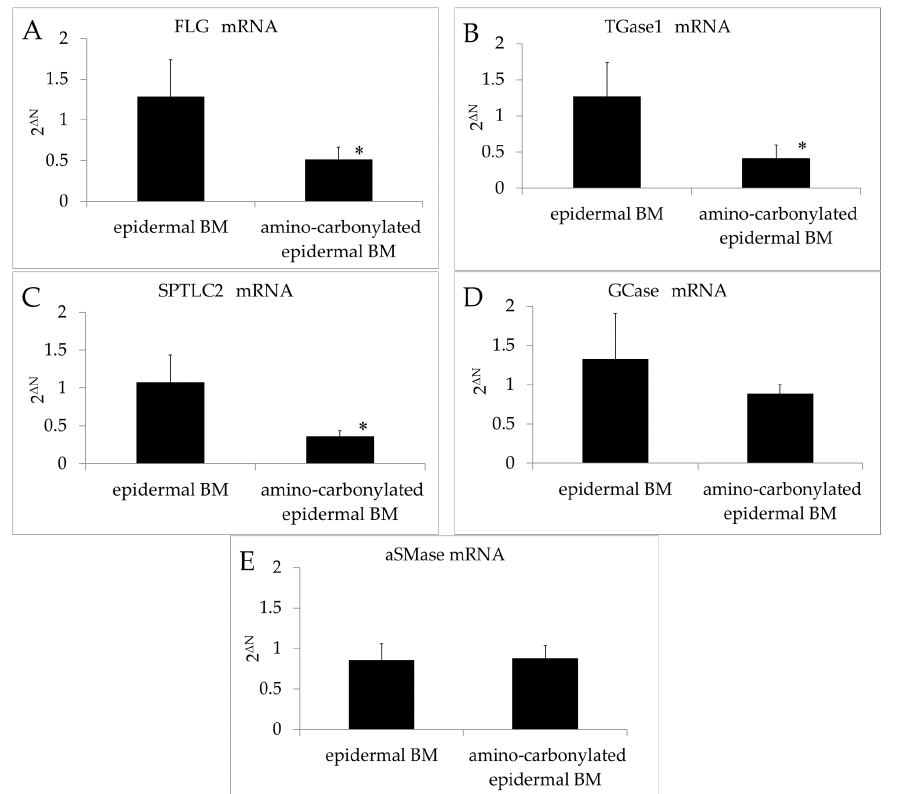
Figure 2. Effects of amino carbonylation of the epidermal BM on FLG, TGase1, SPTLC2, GCase,